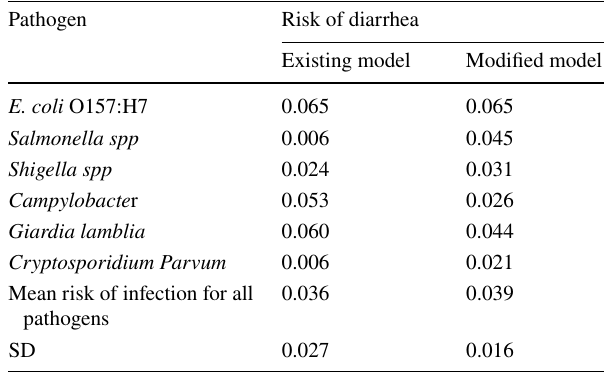
Table 16 Linear comparison of risks of diarrhea obtained using the existing and the modified